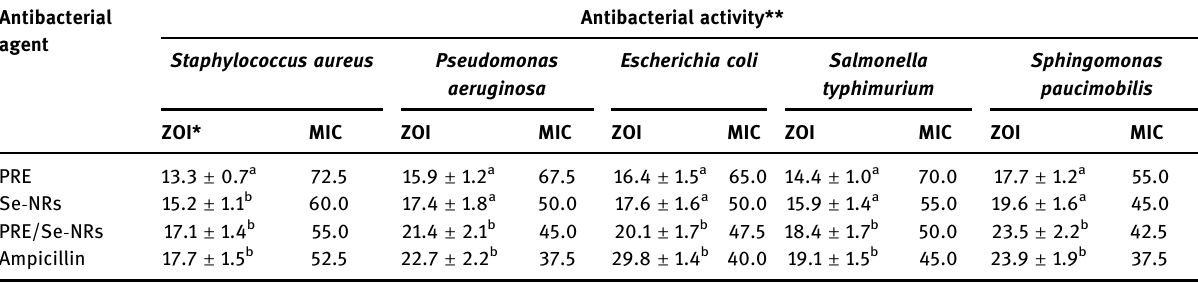
Table 1: Antimicrobial performance of pomegranate rind extract ( PRE ) , biosynthesized selenium nanorods ( Se - NRs ) , and PRE/Se - NRs composites, using zone of inhibition ( ZOI; in mm ) and minimal inhibitory concentrations ( MIC; in mg/L ) assays